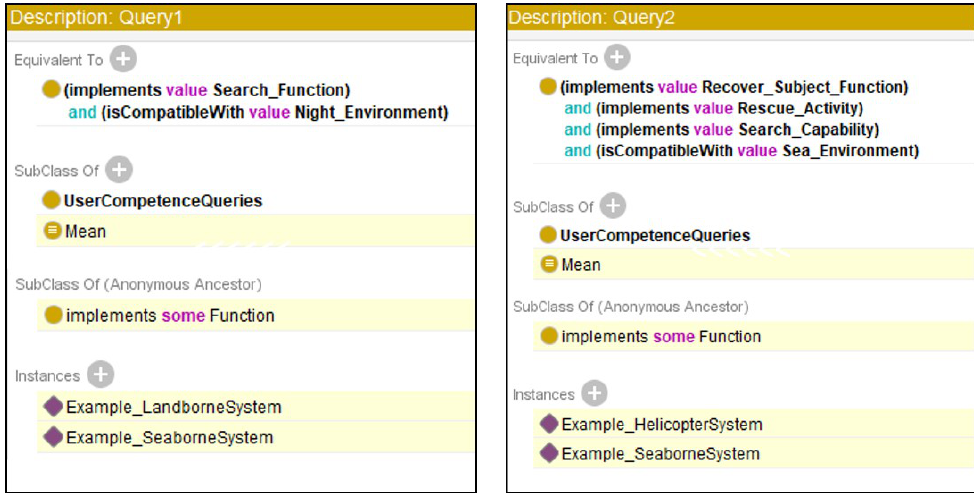
Figure 19. The Query1 and Query2 class definitions with the inferences made by the